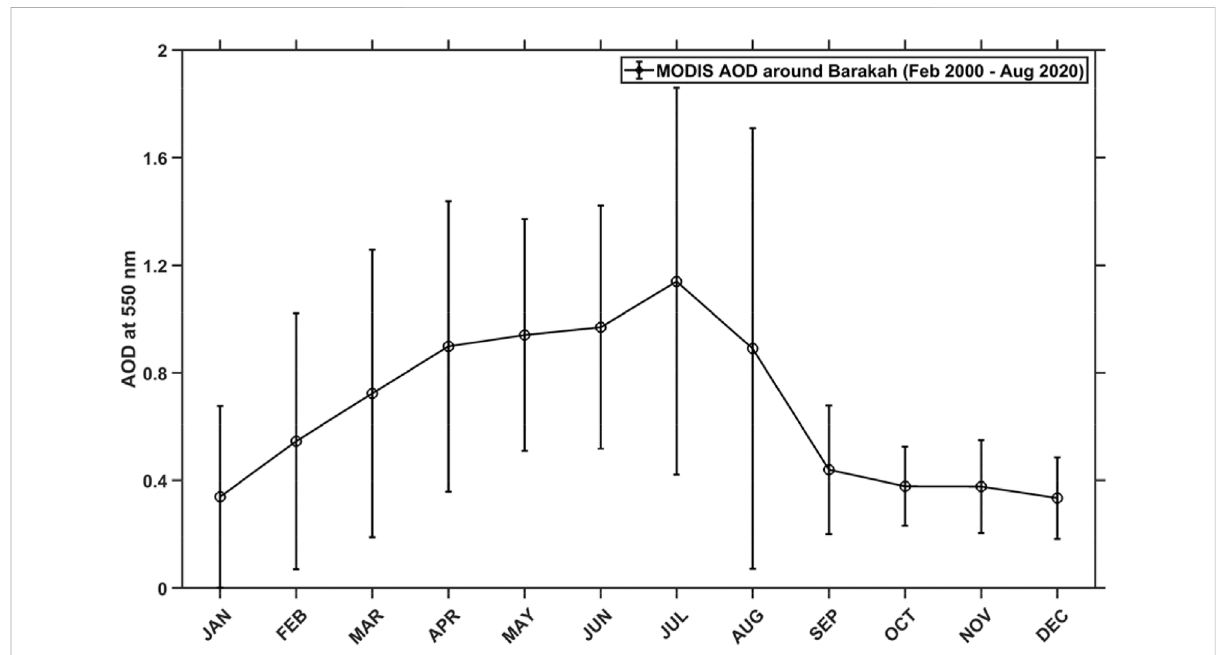
FIGURE 11 Monthly-averaged daily AOD at 550 nm from the MODIS instruments onboard the Terra (February 2000 – August 2020, MOD04_L2; v6.1) and Aqua (July 2002 – August 2020, MYD04_L2; v6.1) satellites around Barakah location (20 km radius, land only). Error bar denotes the one standard deviation from the